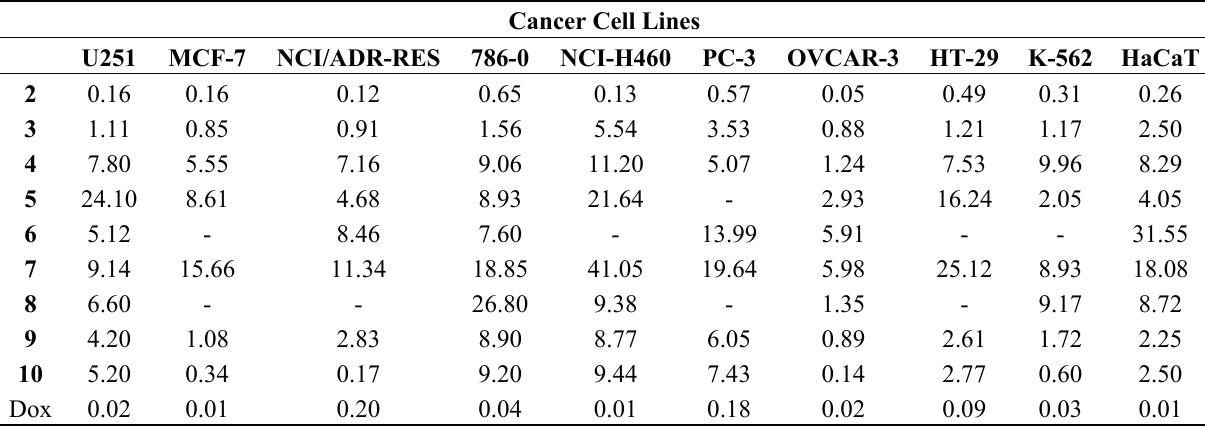
Table 1. GI 50 values (µM) for compounds 2 – 10 in ten tumor cell lines.